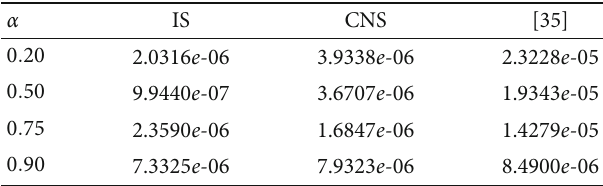
∞ [35] for the Problem